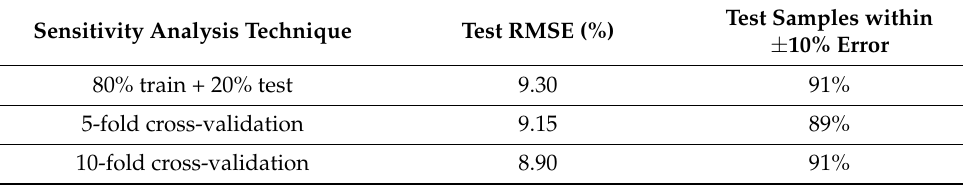
Table 4. Sensitivity analysis of the proposed hybrid